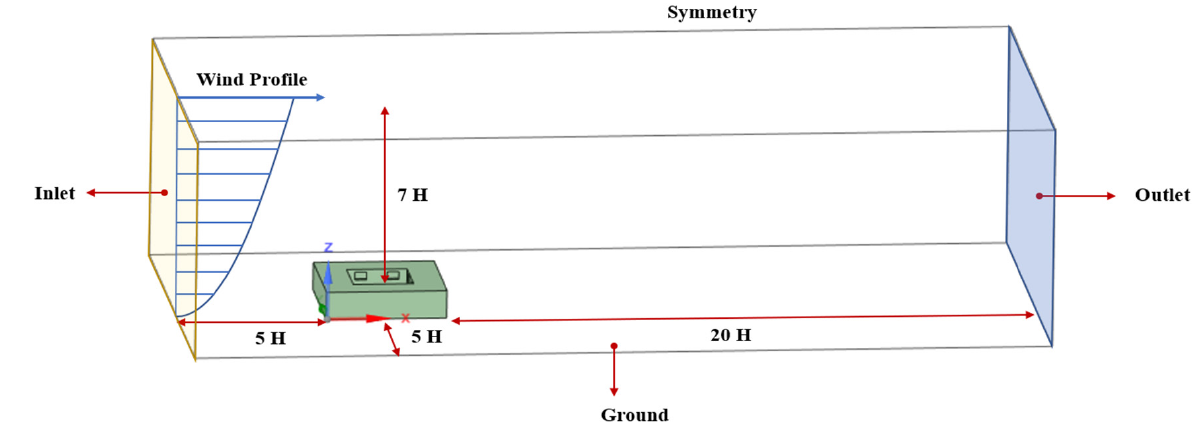
Figure 6. The dimension of the domain and the direction of the wind.